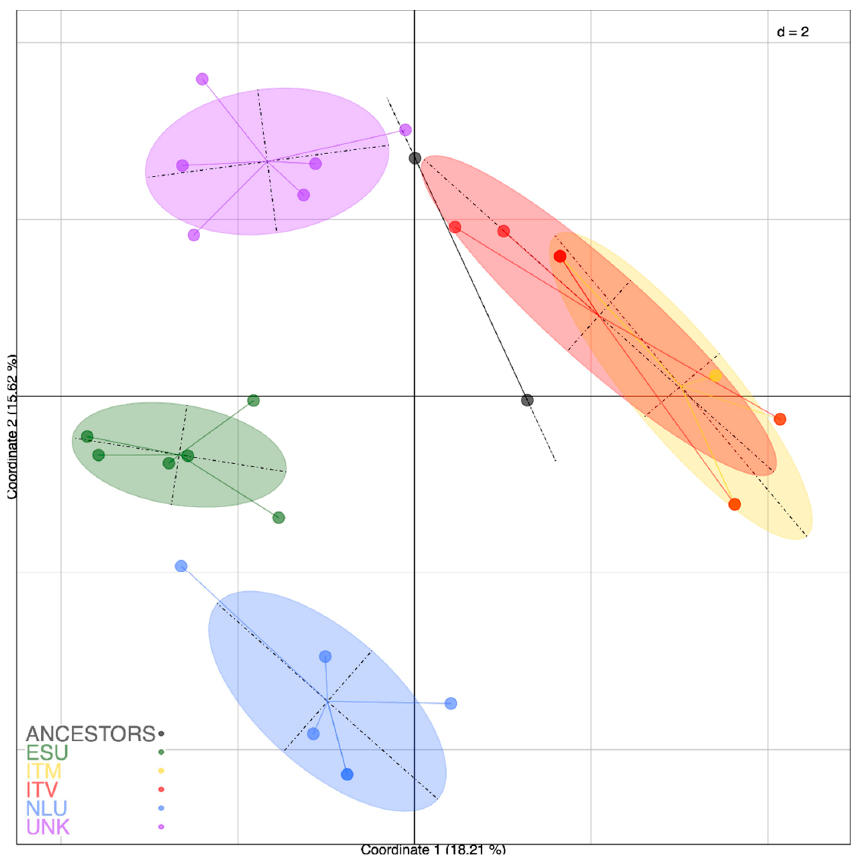
Figure 5. PCoA of the 32 A. araucana samples based on Euclidean distances.